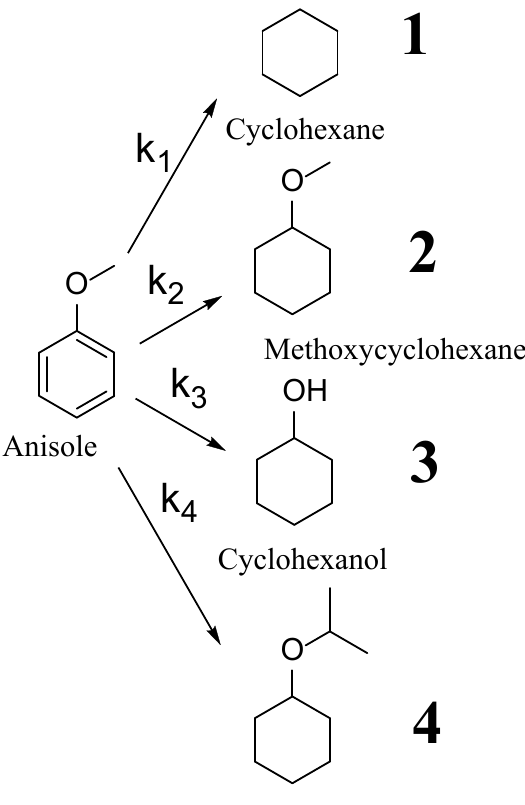
Scheme 1. Kinetic model for the conversion of anisole and the products of transfer hydrogenation in 2-PrOH over high-loaded Ni and Ni–Cu